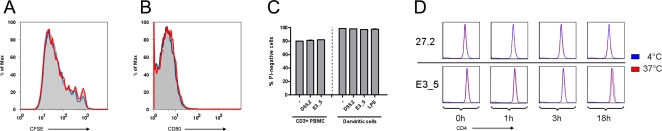
Interaction of DARPins with CD4 has no detectable effect on cell viability and stimulation.(A) PBMC stimulation with IL-2 and OKT3 to induce proliferation was not altered in presence of the CD4-specific DARPin 55.2 (red), the non-binding DARPin E3_5 (blue) or absence of DARPin (gray) over a 4 day period. Proliferation was monitored by flow cytometry by determining CFSE dilution as a result of cell division. One representative experiment out of two is shown. (B) Activation of dendritic cells (DC) as determined by CD80 expression. Neither addition of DARPin 55.2 (red), nor of control DARPin E3_5 (blue), resulted in detectable upregulation of CD80 on DC over a 24 h period. One out of two independent experiments is depicted. (C) Prolonged treatment of T lymphocytes (4 days) and immature monocyte derived DC (24 h) with DARPin 55.2 (CD4 specific) and E3_5 (unselected control DARPin) has no effect on cell viability. Viability was determined by propidium iodide staining. DARPin concentration in the lymphocytes and DC cultures were 500 nM and 375 nM, respectively. (D) Interaction of DARPins with CD4 does not result in downregulation of surface CD4. Untouched peripheral blood CD4+ T cells were cultured in presence or absence of the indicated DARPins for 1 h, 3 h or 18 h at either 37°C (red line) or 4°C (blue line). Cells were stained for CD4 and the expression of surface CD4 was analyzed by flow cytometry. Shown is one representative experiment out of four.